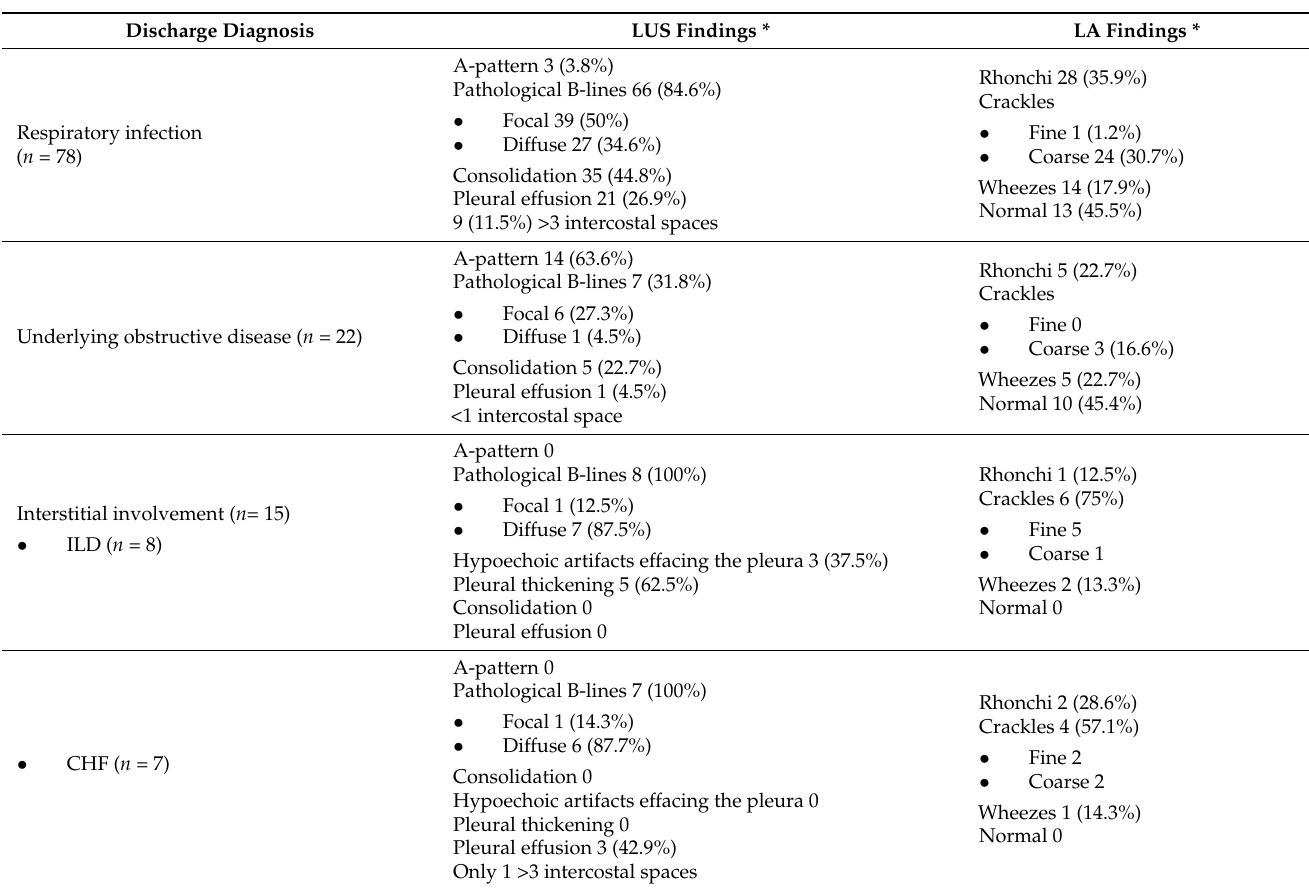
Figure 1. Flow chart. ILD = interstitial lung disease, CHF = Congestive Heart failure, COPD: Chronic obstructive pulmo- nary disease. Table 1. Lung Ultrasound and Pulmonary Auscultation Characteristics per